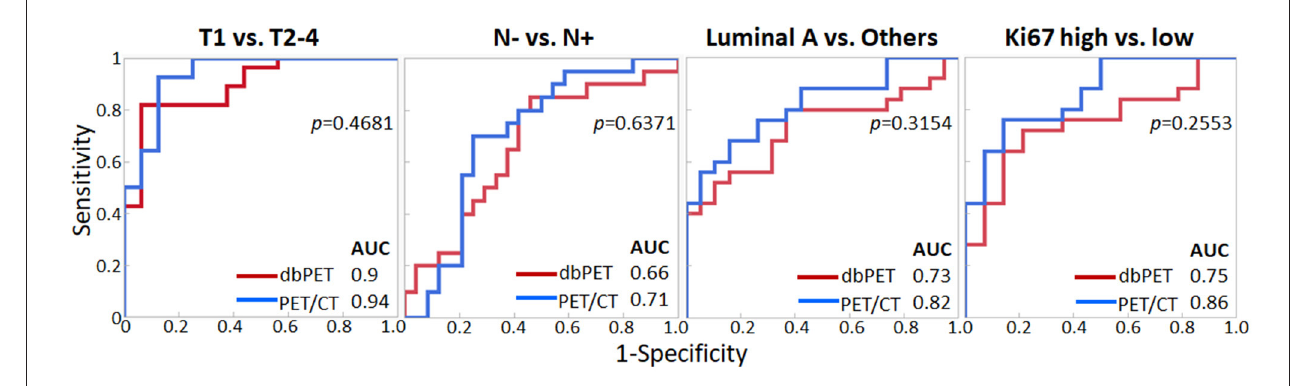
FIGURE 3 | Comparison of ROC analysis for classifying breast cancer characteristics by texture features of dbPET (red line) and whole-body PET/CT (blue line). The AUC values in PCA with texture features of both dbPET and PET/CT were not significantly different. AUC, area under the curve; dbPET, dedicated breast positron emission tomography; CT, computed tomography; PCA, principal component analysis; ROC, receiver-operating-characteristic.